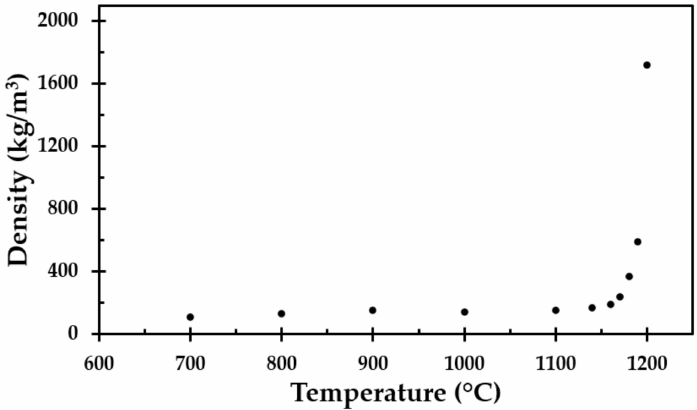
Figure 6. Density as a function of the heat exposure